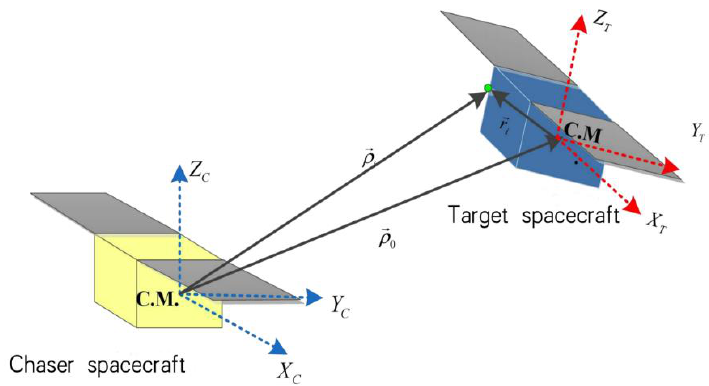
Figure 3. Feature points of the target spacecraft.